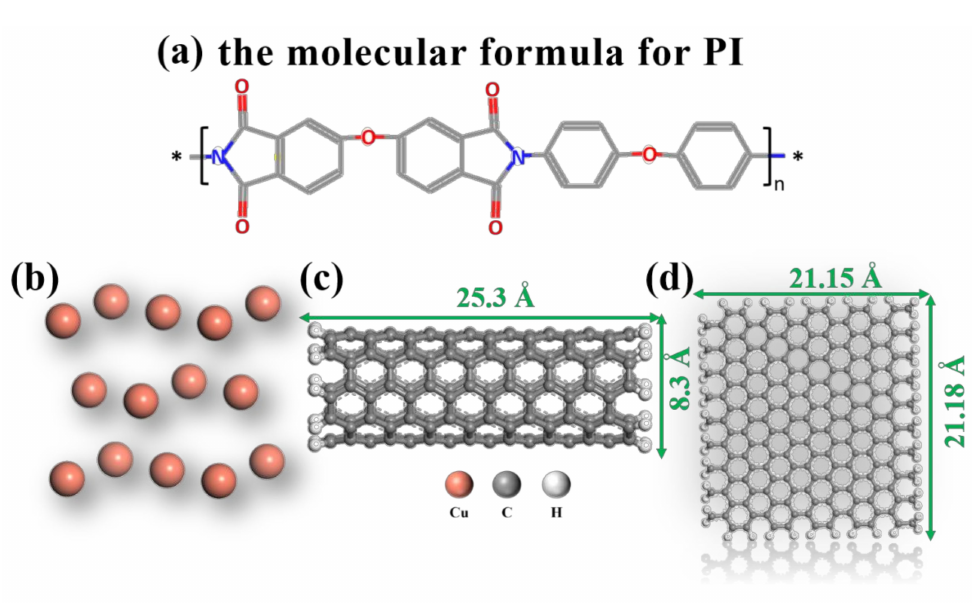
Figure 1. Structural information of ( a ) PI, ( b ) Cu, ( c ) CNT, and ( d )